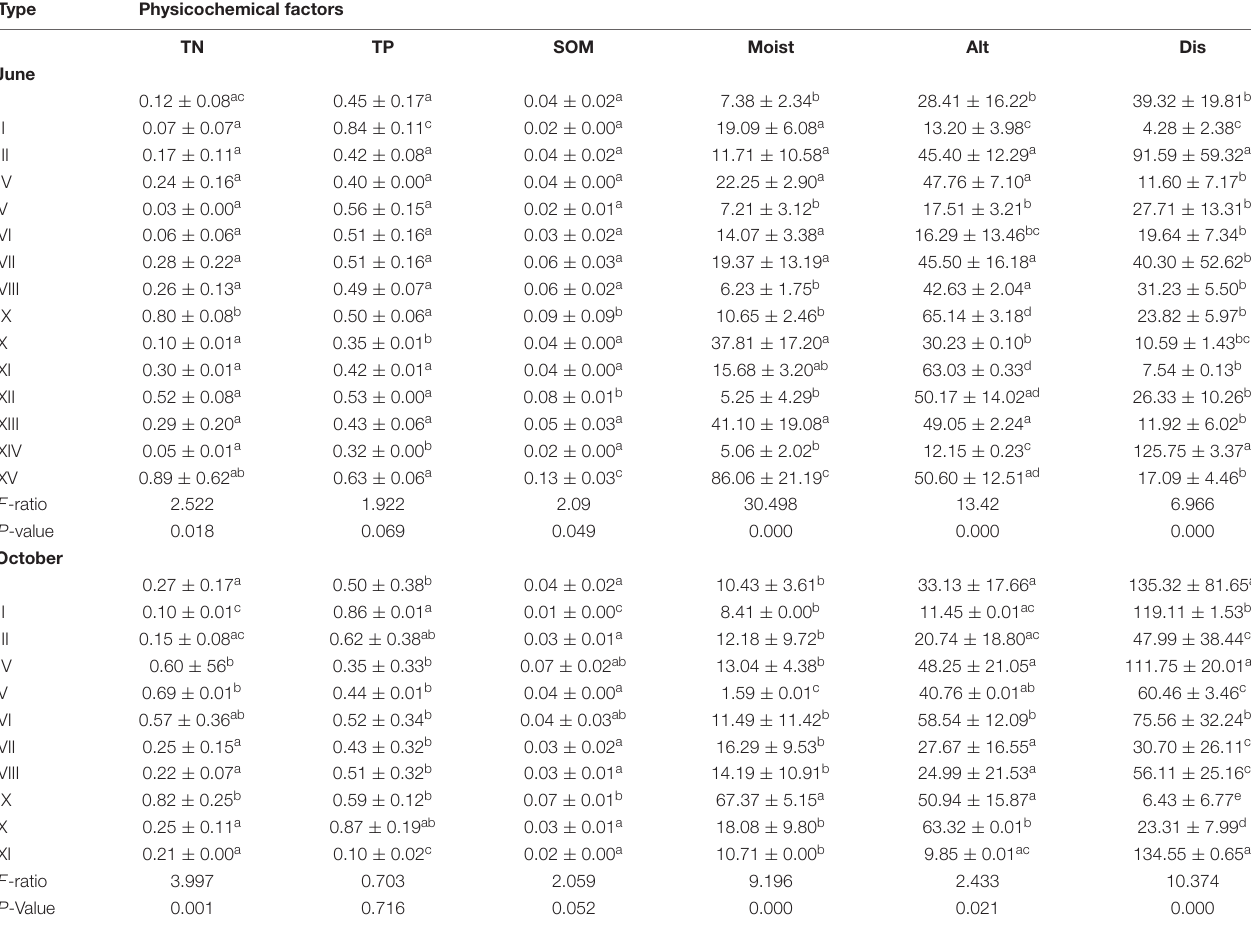
TABLE 3 | Mean values ( ± standard deviations) of environment factors along with one-way ANOVA comparing clustered vegetation